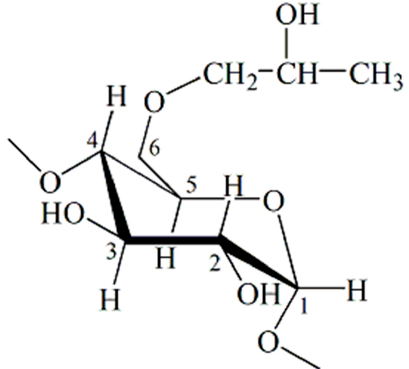
Figure 2. Chemical structure: ( a ) N-isopropylmethacrylamide, ( b ) N-isopropylacrylamide and ( c ) ethylene glycol dimethacrylate.